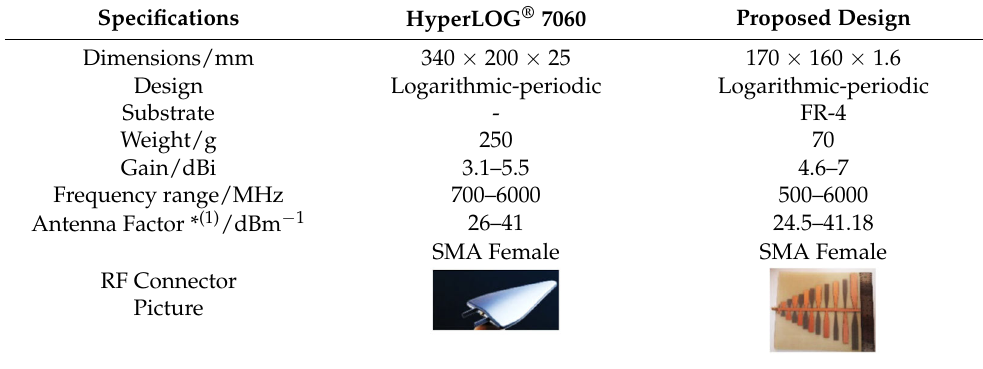
Table 5. Comparison between the proposed antenna and commercial antenna.